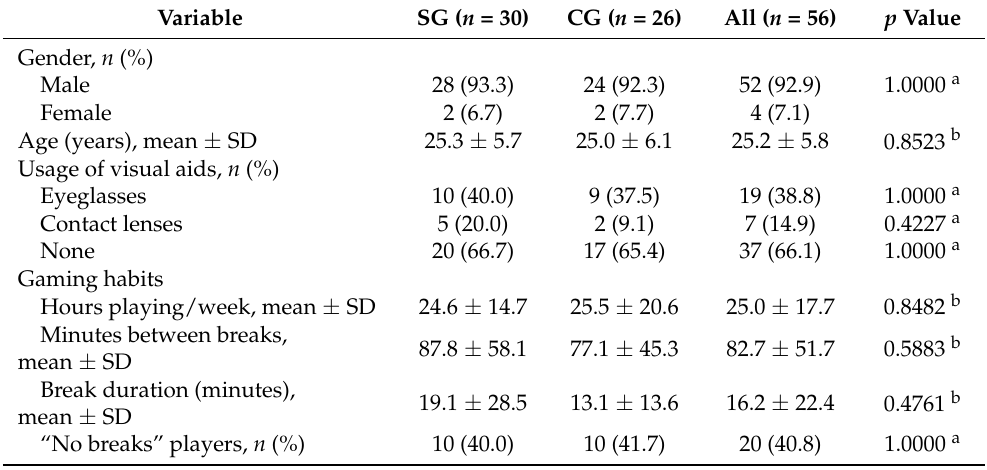
Table 1. Demographic and clinical characteristics and self-reported gaming habits of the